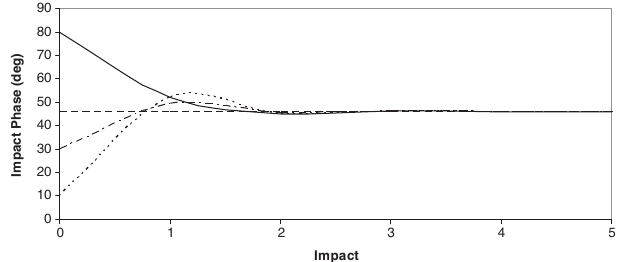
FIG. 6. Phase focusing of the electrons towards the resonant phase for electrons starting at the incorrect phase.